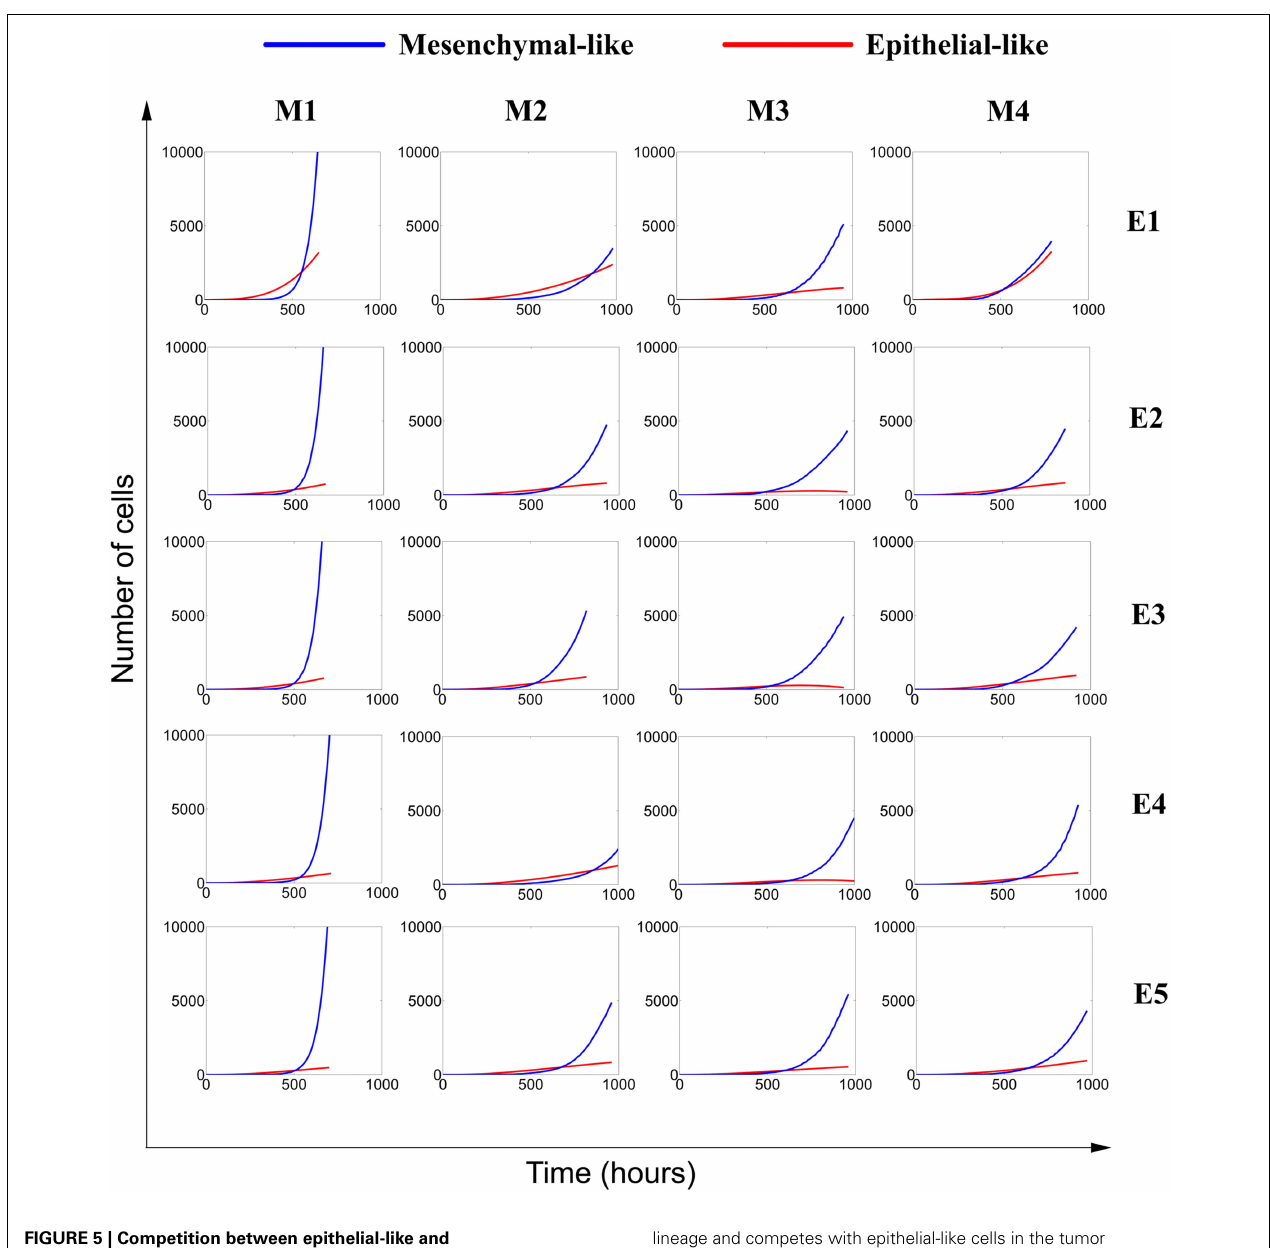
FIGURE 5 | Competition between epithelial-like and mesenchymal-like cells in a growing avascular tumor. Tumor growth initially begins as a homogenous mass of epithelial-like cells with low motility and high adhesion.When the tumor includes 50 cells, one of the cells randomly mutates into a mesenchymal-like cell with high motility and low adhesion.The mesenchymal cell generates its own